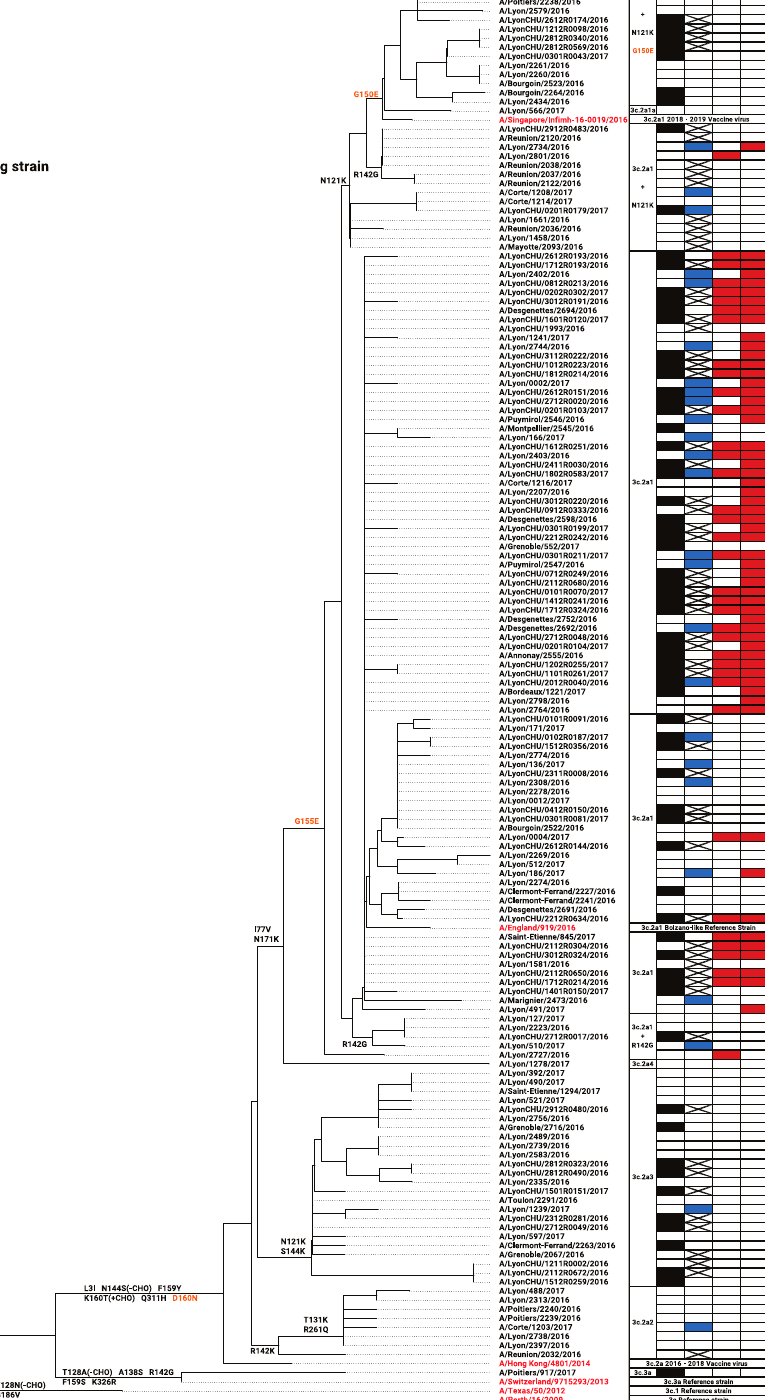
Figure 2. Phylogenetic tree constructed using hemagglutinin genes from the 155 subjects of the 2016–2017 season for whom the whole influenza consensus genome was successfully sequenced and representatives of the A(H3N2) clades. Every substitution concerning antigenic sites were reported on branches. Neuraminidase (NA) V263I or non-structural protein 1 (NS1) K196E presence, severity, and vaccination status of the patient they are associated with, and the clade in which they belong, is reported next to each